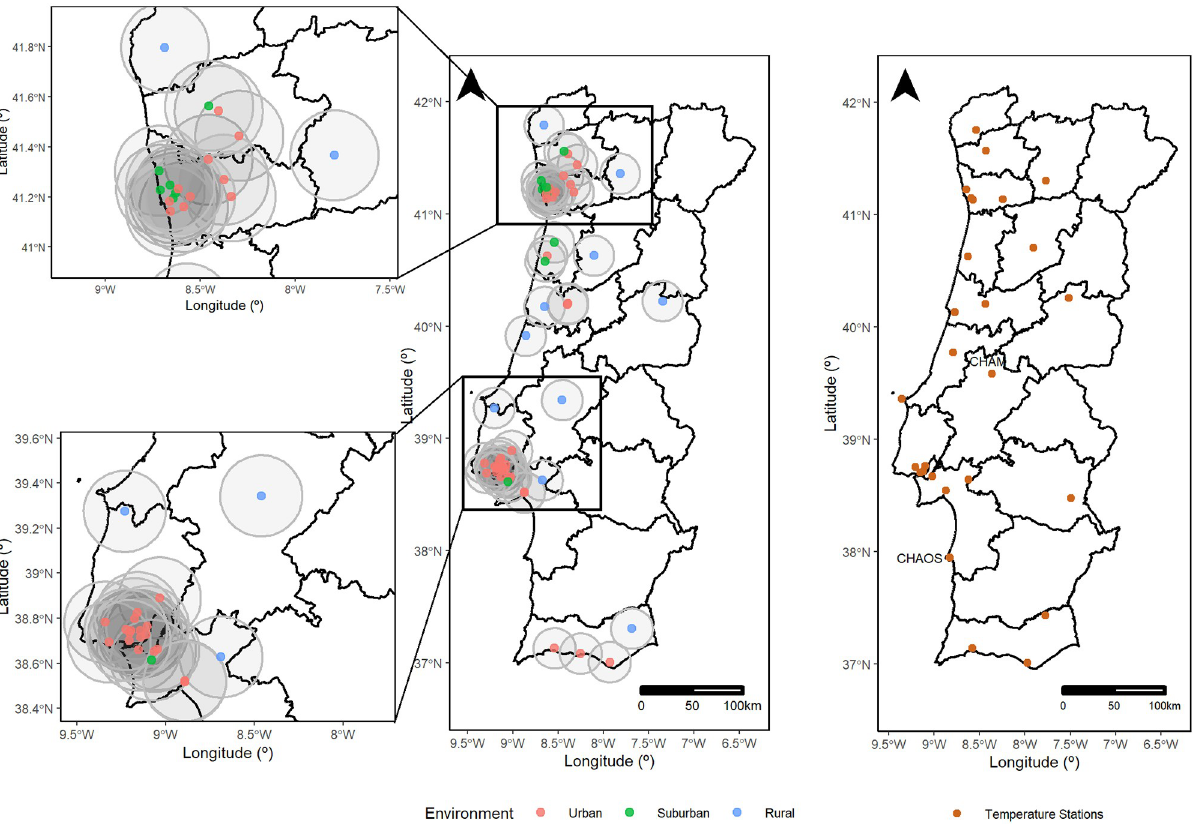
Fig 3. Portugal mainland maps and zooms over Lisbon and Porto districts. (a) air quality stations and (b) temperature monitoring stations. The grey circles represent the 20km radius of influence centered at each air quality station. The Portuguese limits and borders were constructed using the geographical information from the Carta Administrativa Oficial de Portugal 2017 (available for non commercial use at https://www.dgterritorio.gov.pt/ cartografia/cartografia-tematica/caop).